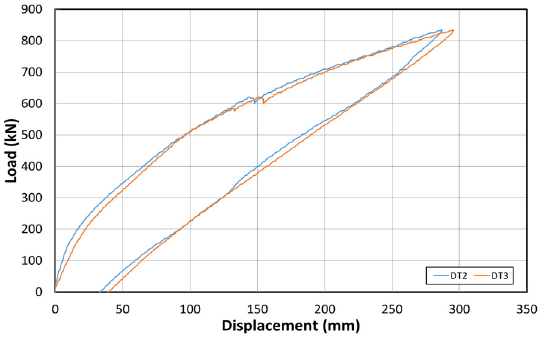
Figure 19. Load–displacement curves after reinforcement based on the NSM method.